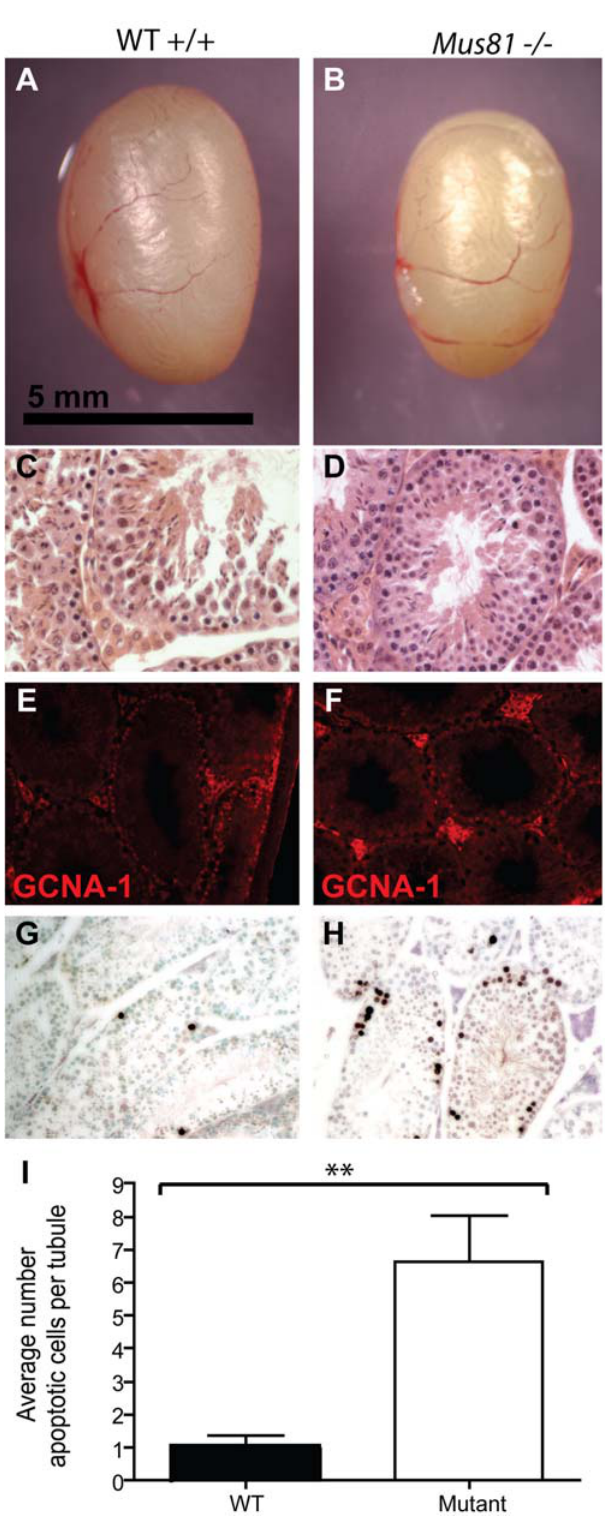
Figure 1. Mus81 2 / 2 male mice have reduced testes size and sperm number. Testes from WT (A) and Mus81 2 / 2 (B) mice were removed, weighed and photographed. Scale bar 5 mm. C, D) Respectively, WT and Mus81 2 / 2 testes sections stained with H&E. E, F) WT and Mus81 2 / 2 testes sections stained with antibody to GCNA-1 raised in rat (red). G, H) WT and Mus81 2 / 2 testes sections TUNEL